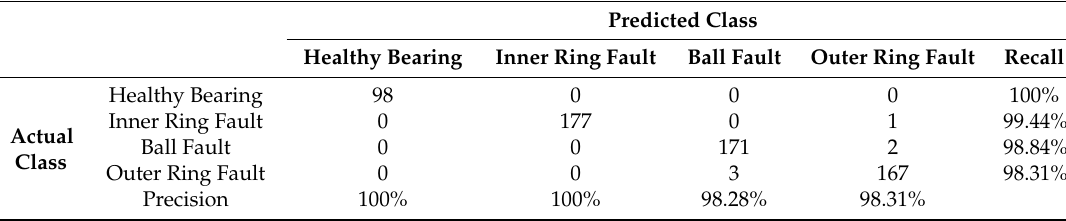
Table 5. Classification rate for Back-Propagation neural network (Validation data).